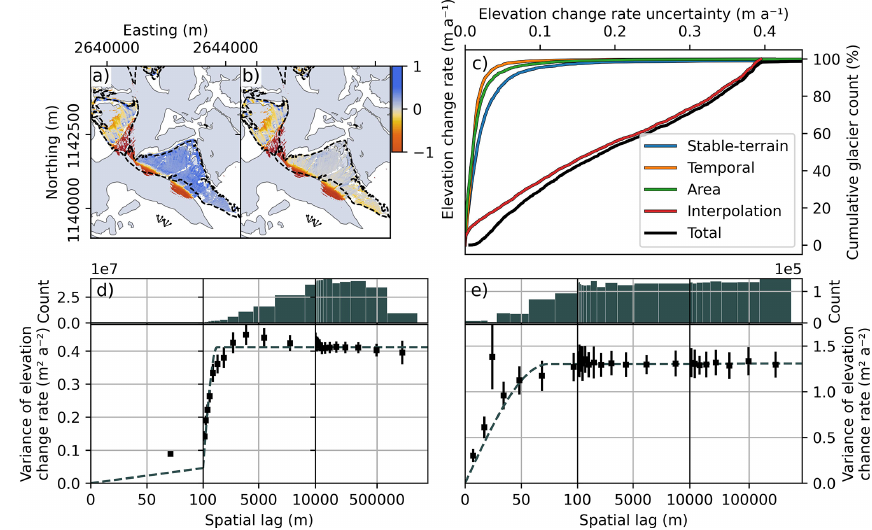
Figure 4. Error figure ensemble. (a, b) Individual DEM difference before (a) and after (b) co-registration. The arrows indicate the locations and directions of the images used for generating the ca. 1931 DEM. The dashed lines indicate the theoretical viewshed of the stereo pair (pre- calculated by swisstopo). (c) Cumulative histograms showing the magnitude of the different components for the elevation change uncertainty of each individual glacier. (d, e) Variograms of interpolated (d) and stable-terrain (e) elevation difference uncertainties, showing the variance of all pairs of pixels at a given distance (or lag) as a function of that lag. The individual markers show the empirically derived variance; their error bars show their 95% confidence intervals; the dashed line shows the variogram model (sum of two spherical models). The histograms above the variograms show the pairwise sample count for each empirically derived variance